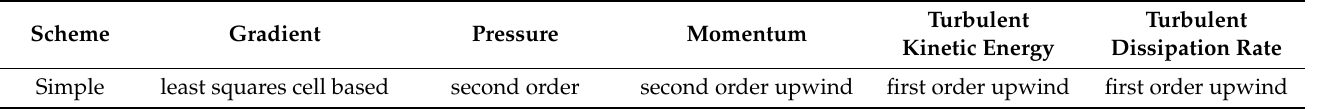
Table 4. Solution Table 4. Solution settings.